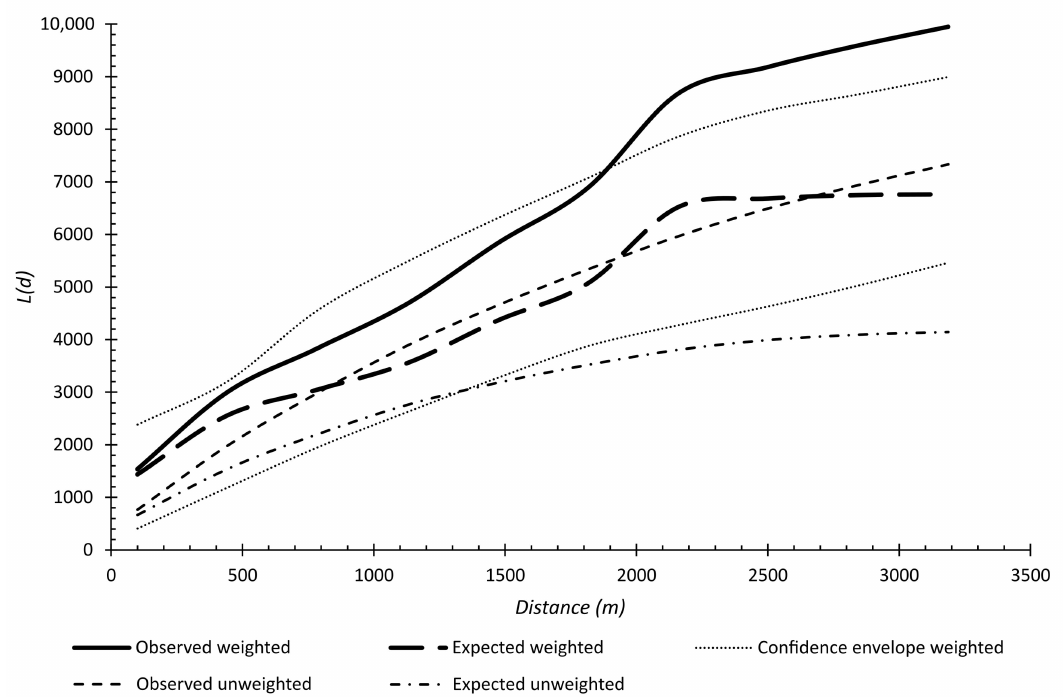
Figure 2. Weighted and unweighted L-functions for ICT firms in Ostrava (2019). For the needs of suitable geovisualization of hubs using the kernel density method, we used incremental spatial autocorrelation to determine the distance bandwidth parameter. We used 10 distance bands with a beginning distance and an increment of 135 m without row standardization. Only one max peak at a distance of 675 m was detected. Subsequently, hubs were modelled using kernel density. The number of employees was used in the population field and the search radius was set to 675 m. The result was stored in a raster with a 10-m cell size. Subsequently, the hubs were extracted by filtering the values on the 99th percentile and visualized using a multi-part colour scheme. The results of this procedure were nine well identifiable ICT hubs within the city (see Figures 3 and